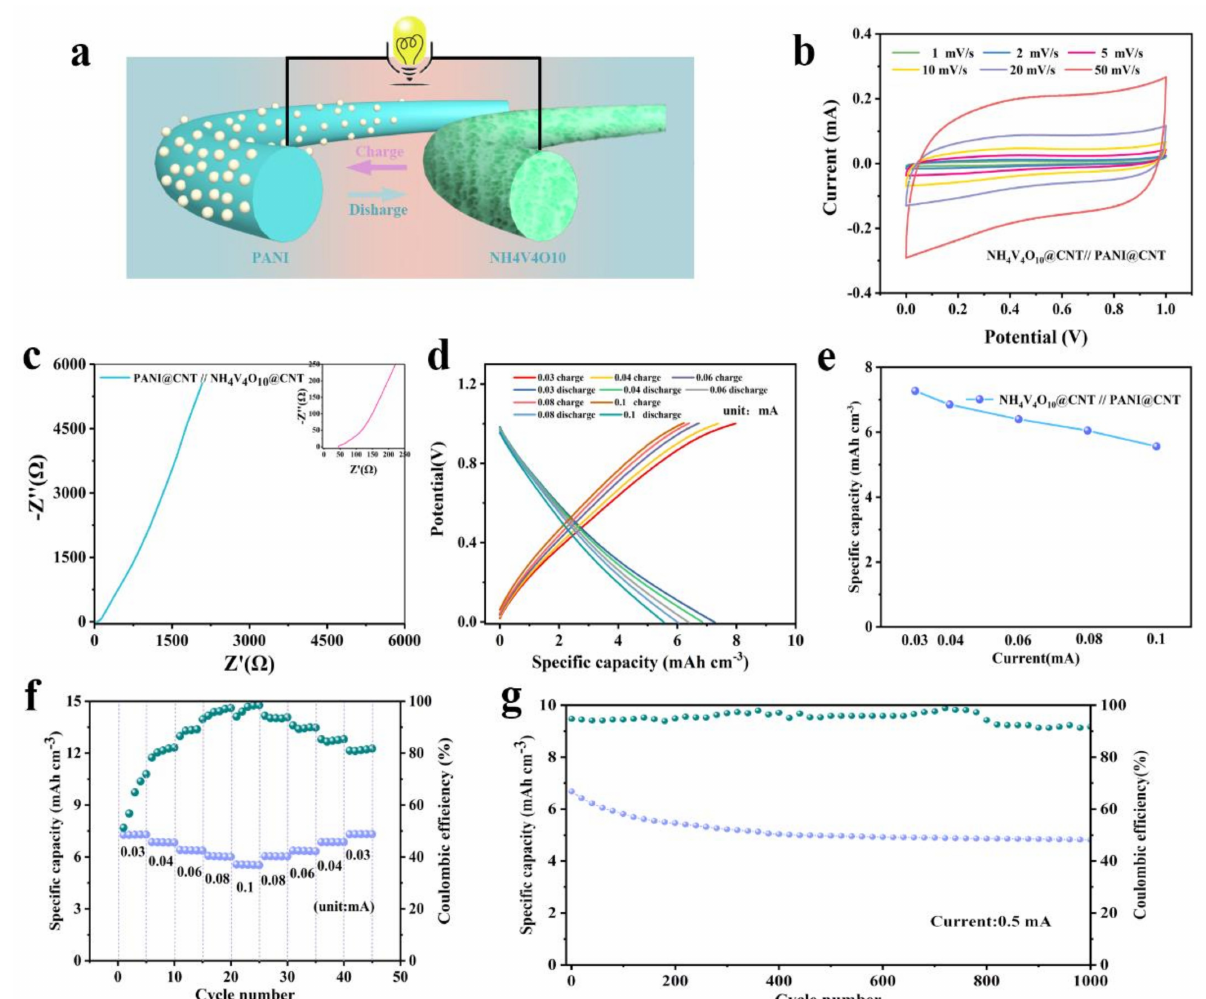
Figure 6. Electrochemistry properties of the aqueous NH 4 V 4 O 10 @CNT//PANI@CNT full cell. ( a ) Schematic illustration of the fiber battery full cell. ( b ) CV curves of the full cell at different scan rates. ( c ) EIS profile and inset EIS curve with the high-frequency region. ( d ) Galvanostatic charge/discharge curves of NH 4 V 4 O 10 @CNT//PANI@CNT fibers full cell at different current densi- ties. ( e ) Specific capacity at different current densities. ( f ) Rate performance of the full cell at different currents from 0.03 to 0.1 mA. ( g ) Long-term cycle performance at a current of 0.5